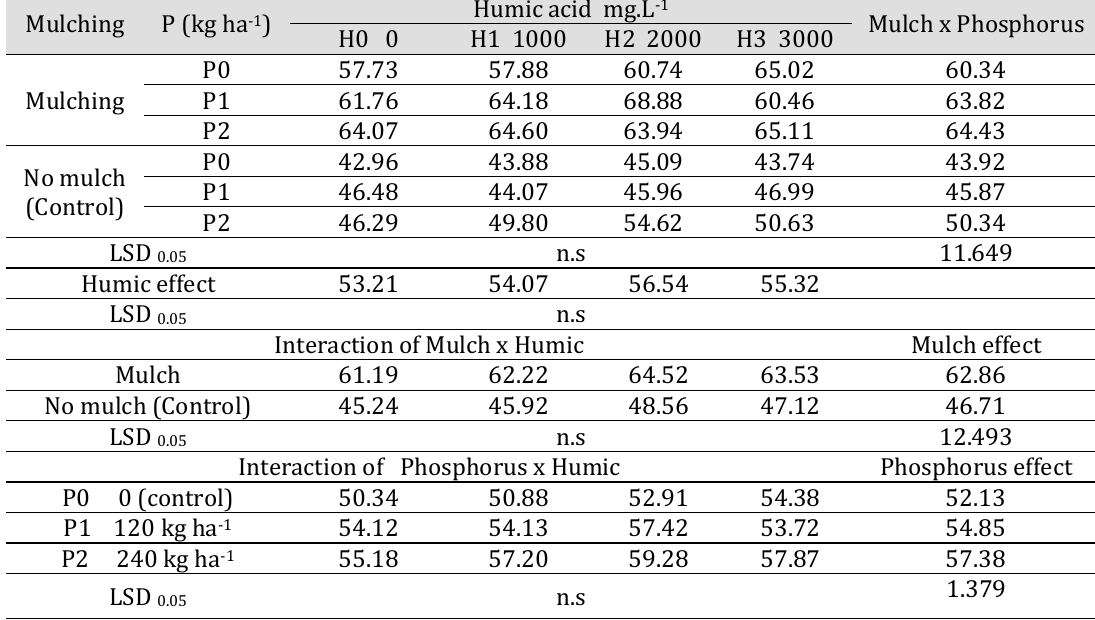
Table 3. Effect of soil mulching, phosphorus, and humic acid on the number of leaves per plant.